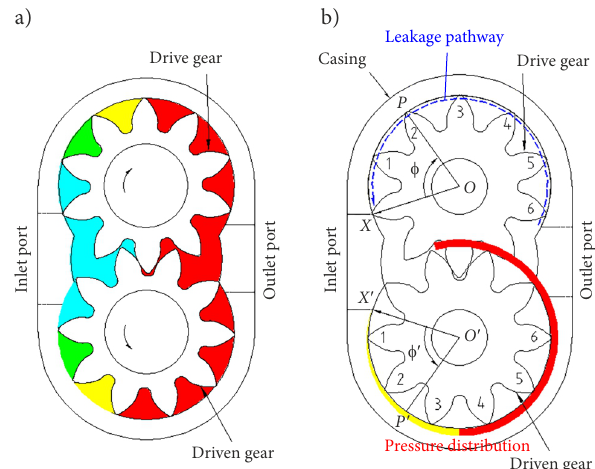
Figure 3. Pressure distribution on the pump casing (a) and on the gears (b), and the coordinate systems used in the presentation of the simulation results